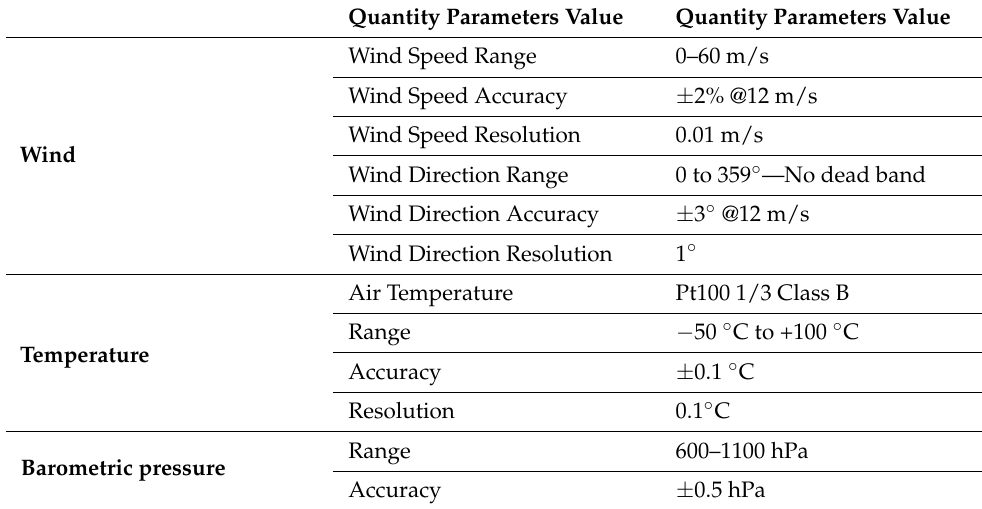
Table 4. Technical characteristics of the used